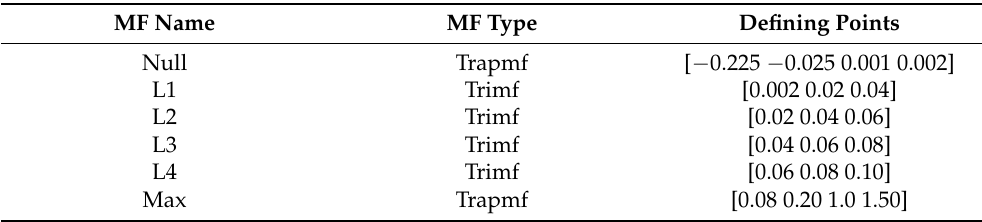
Figure 13. A surface that summarizes the interactions between the rules and membership functions using the output value for each pair of input values. Representation with a small mesh so the details of transitions can be appreciated.